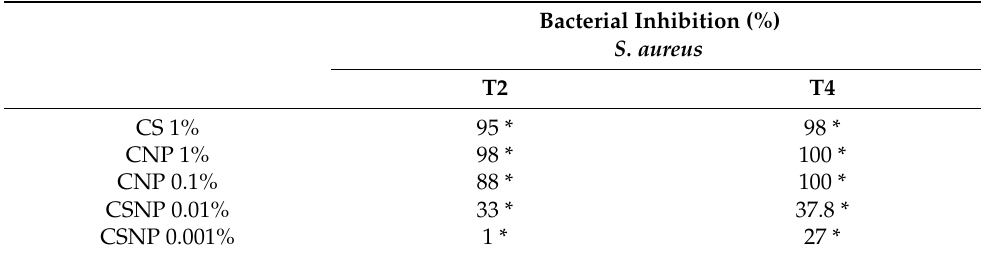
Table 4. Inhibition values (in%) obtained in the dynamic contact tests against S. aureus in leather sam- ples from the dyeing process (D) treated with chitosan CS 1%, or chitosan nano/microformulations (CNP 1% and 0.1%, and CSNP 0.01% and